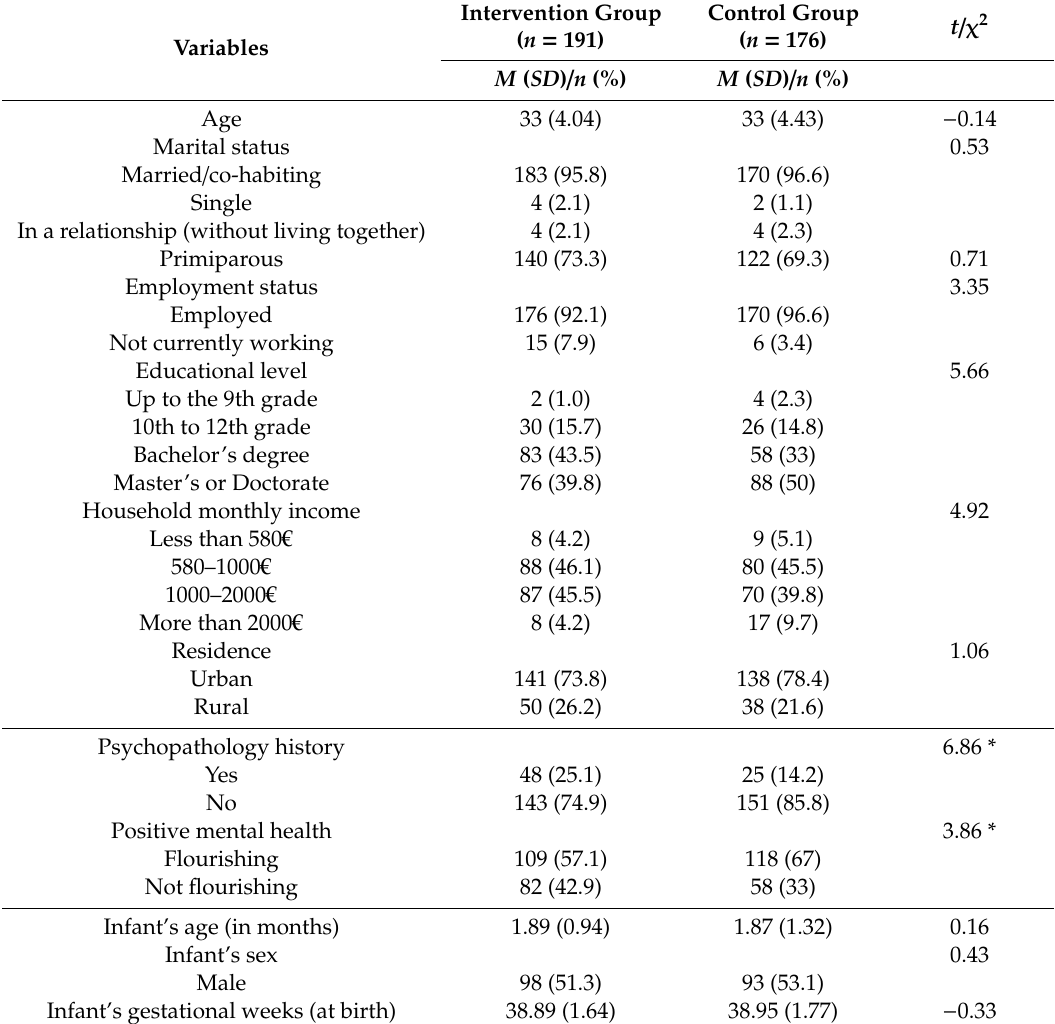
Table 1. Participants’ sociodemographic and clinical characteristics at